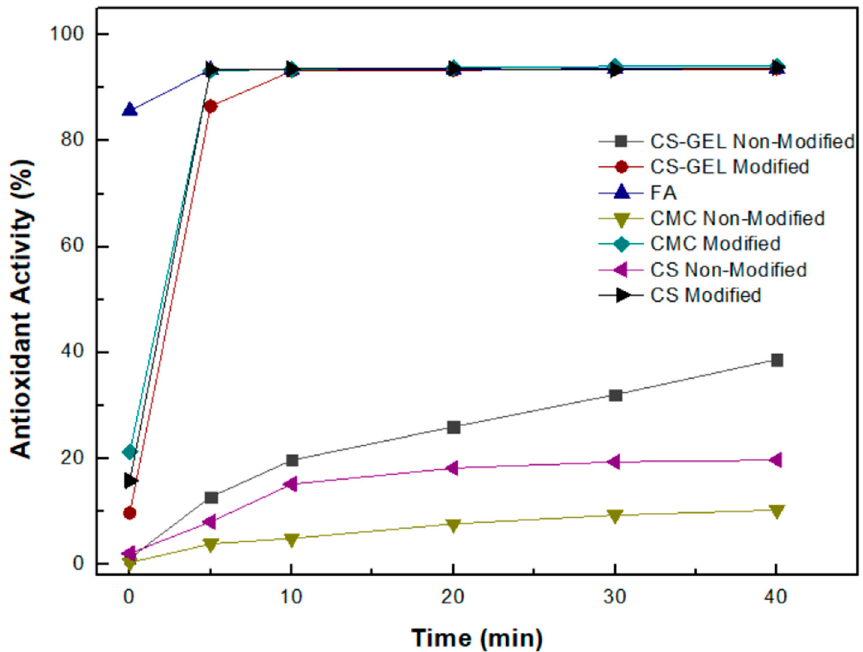
Figure 10. Percentage antioxidant activity of the individual biopolymers and the enzymatically modified biopolymers with ferulic acid, according to the protocol of oxidized ABTS, as a function of time. (The standard deviation was less than 5% in all cases.)